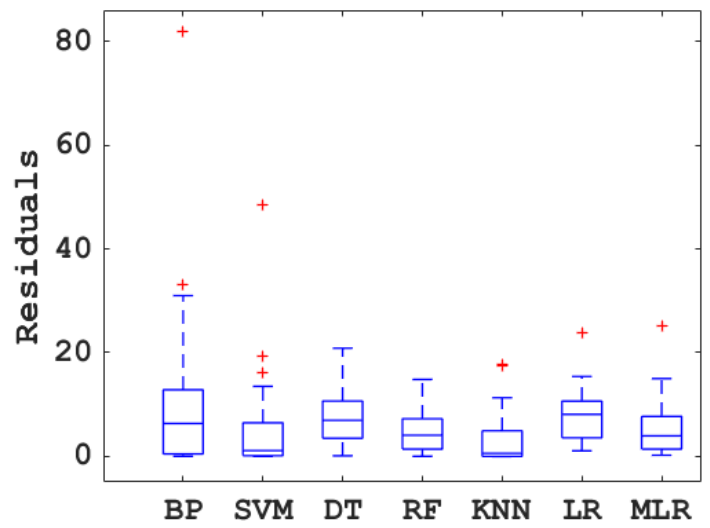
Figure 9. Box plot of the prediction error of different models (+ represents the maximum